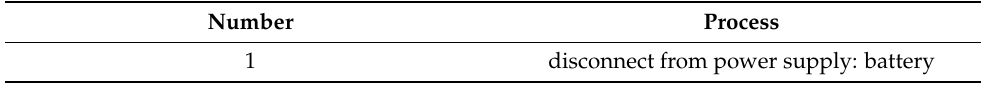
Table A7. Activities of the main processes “classification” and “disassembly”: discharge battery.